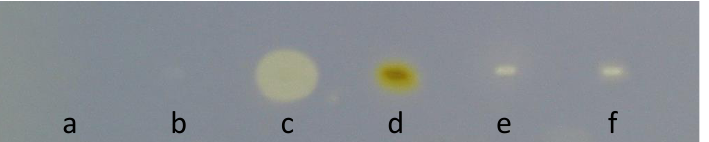
Figure 2. COX-2 TLC assay with 50 µ g of various natural products: ( a ) caffeine, ( b ) coumarin, ( c ) ascorbic acid, ( d ) quercetin, ( e ) sitosterol, ( f ) betulinic acid.